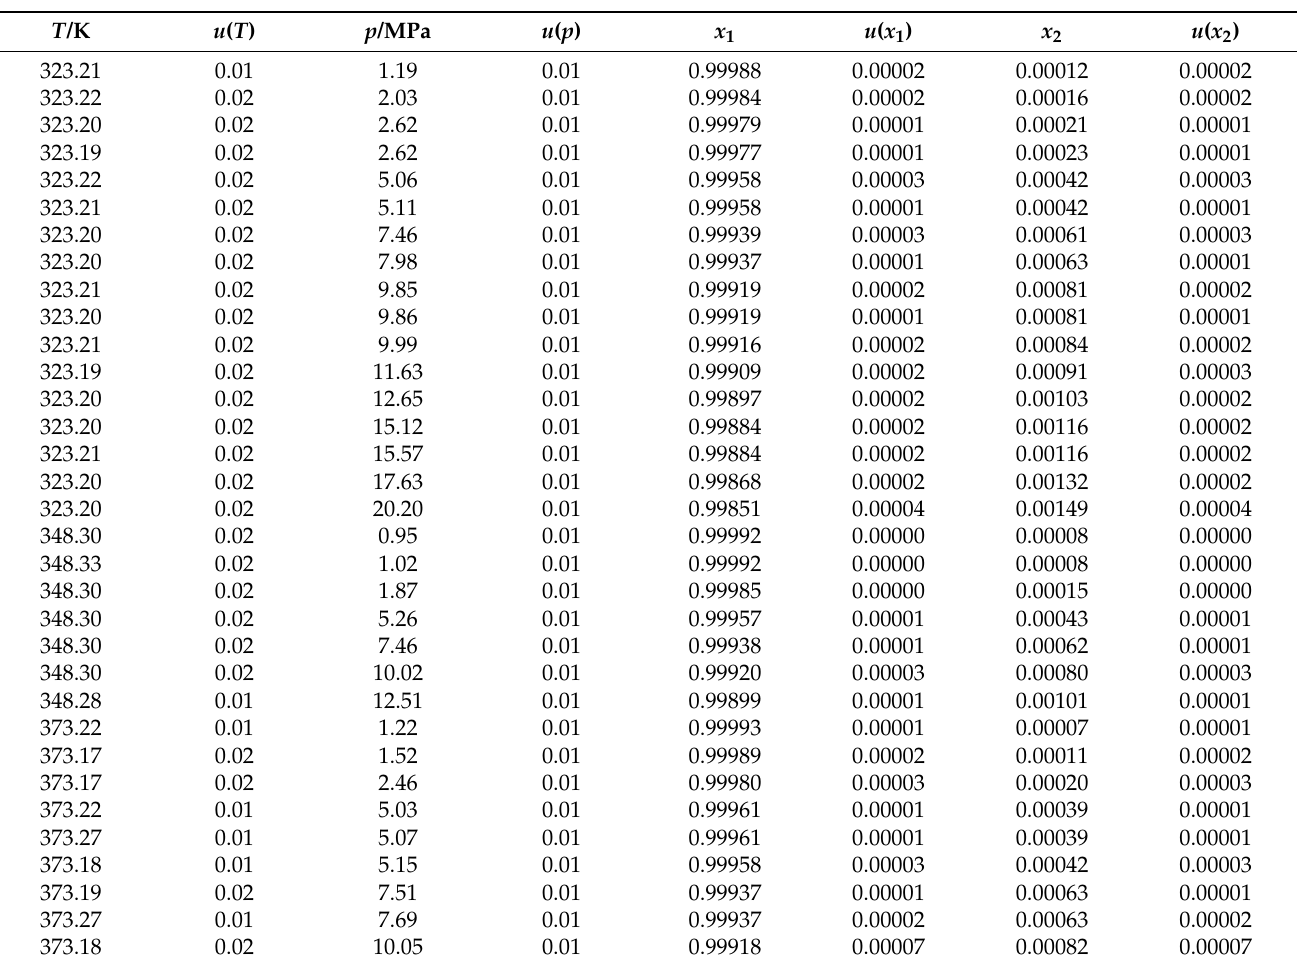
Table 7. Experimental liquid-phase data for the H 2 O(1) + N 2 (2) system at different temperatures, T , and pressures, p . x and u denote the mole fraction in the liquid phase and standard uncertainty,